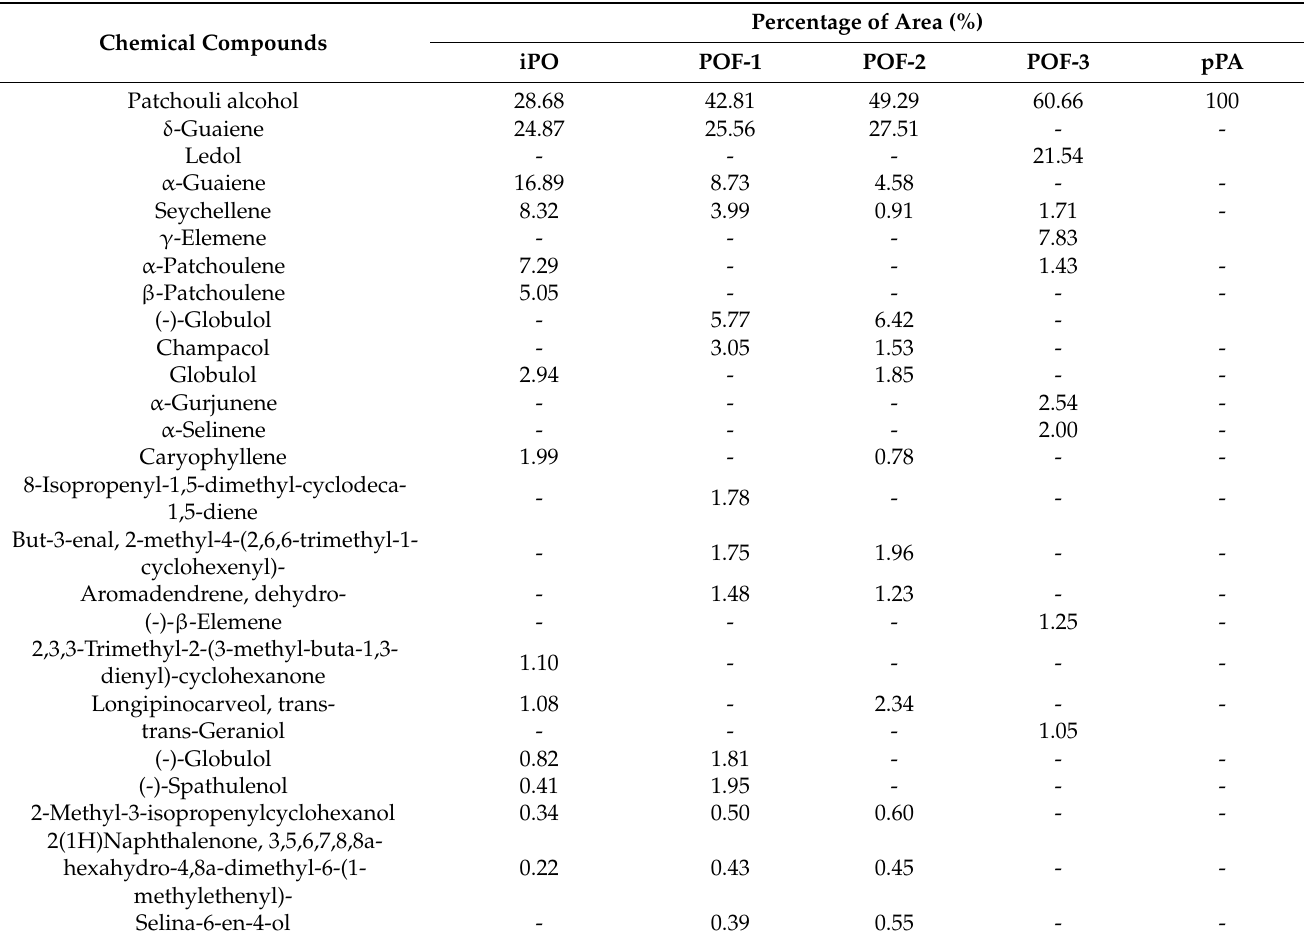
Table 1. Results from GC-MS analysis on iPO, POFs, and